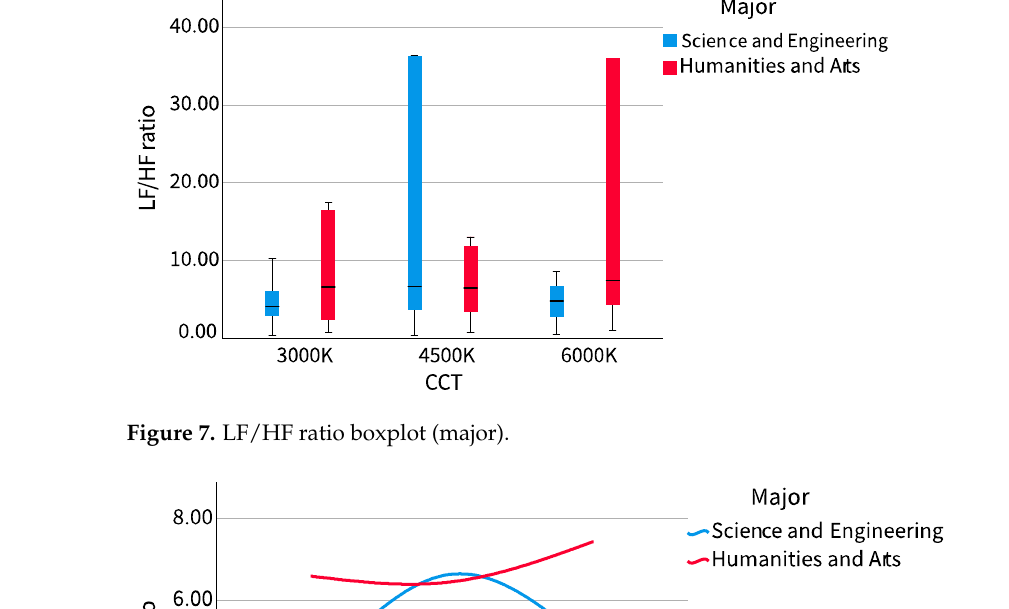
9 of 20 Figure 5. LF/HF ratio boxplot (sex).